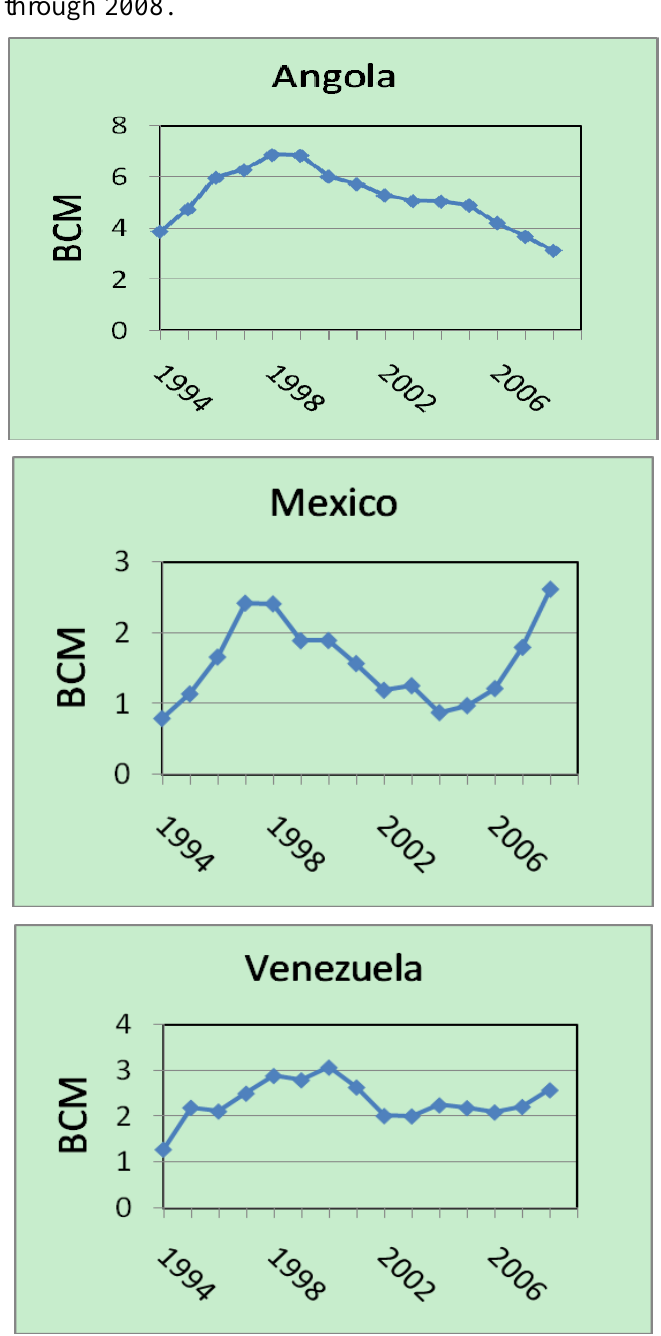
Figure 12. Angola, Mexico and Venezuela were three of the seventeen countries that exhibited a gas flaring peak near the middle of the time series. Gas flaring in Angola has been steadily declining in recent years. In contrast Mexico had a major increase in gas flaring from 2005 through